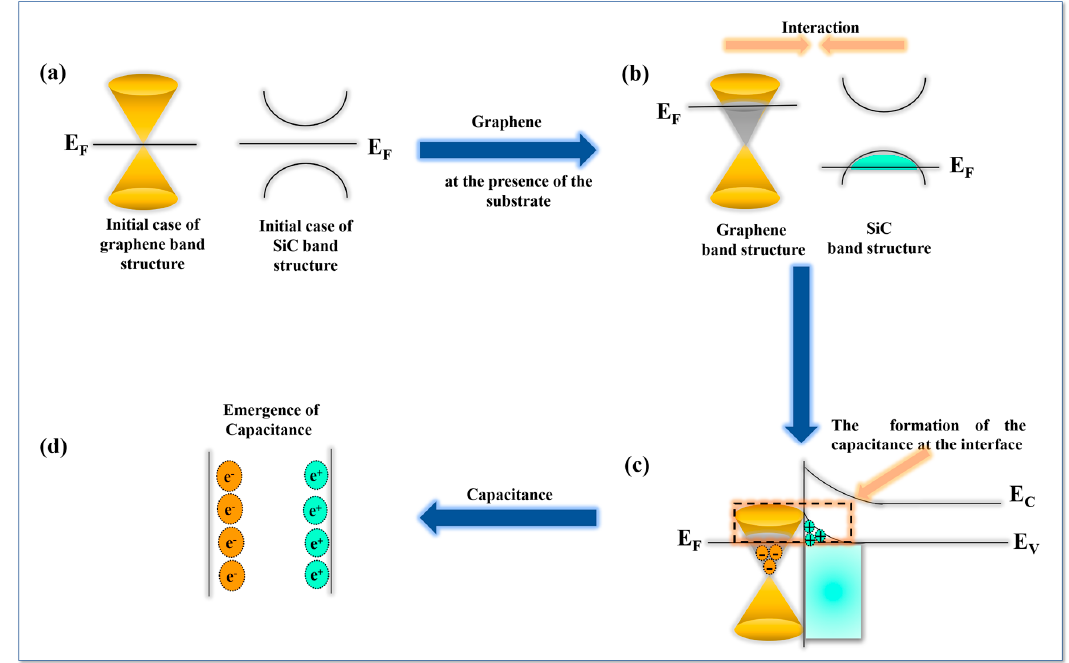
Figure 12. Capacitor effect in epitaxial graphene: ( a )—electronic bands in graphene and SiC substrate separately. The graphene spectrum shows the Dirac point at the Fermi level, while the SiC spectrum shows a gap; ( b )—graphene -SiC system interactions induces changes in the bands. The Dirac cone positioned under the Fermi level, corresponding to n-doping in graphene. The SiC conduction band moves above the Fermi level, corresponding to hole doping; ( c )—The charge redistribution at the graphene-SiC interface results in negatively charged graphene and positively charged SiC surface layer; ( d )—The density of charge leads to the emergence of the capacitor effects at the graphene-substrate interface, which can be modelled as a parallel plate capacitor.